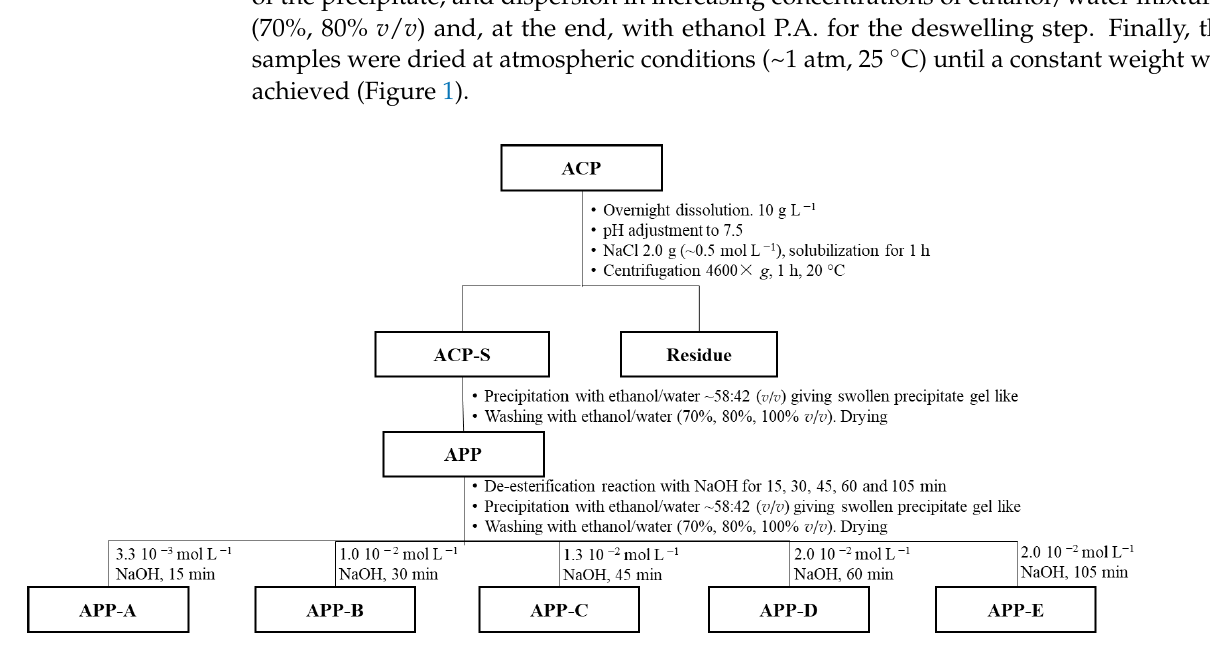
Figure 1. Scheme of purification and de-esterification of pectins from the pulp of Araçá ( Psidium cattleianum Sabine)